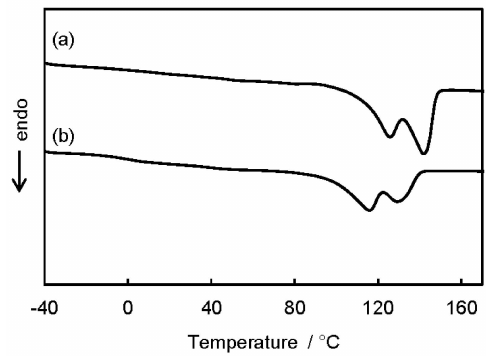
Figure 5. DSC curves of ( a ) P3HB3HH 6 monolith (100 g ¨ L ´ 1 ); and ( b ) P3HB3HH 11 monolith (100 g ¨ L ´ 1 ).